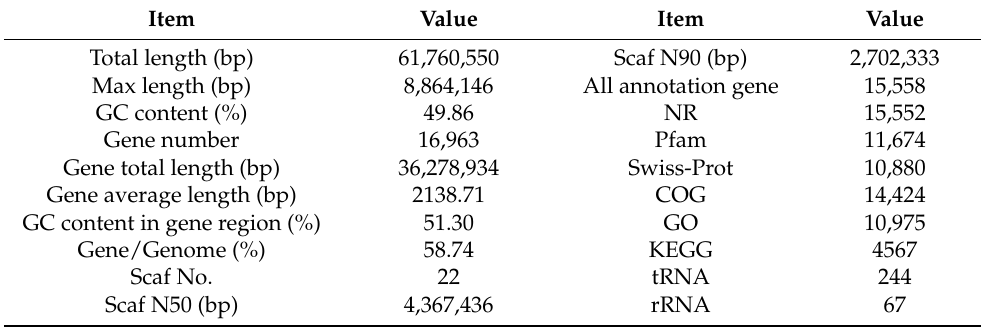
Table 1. Genomic assembly and functional annotation of D. alcacerensis